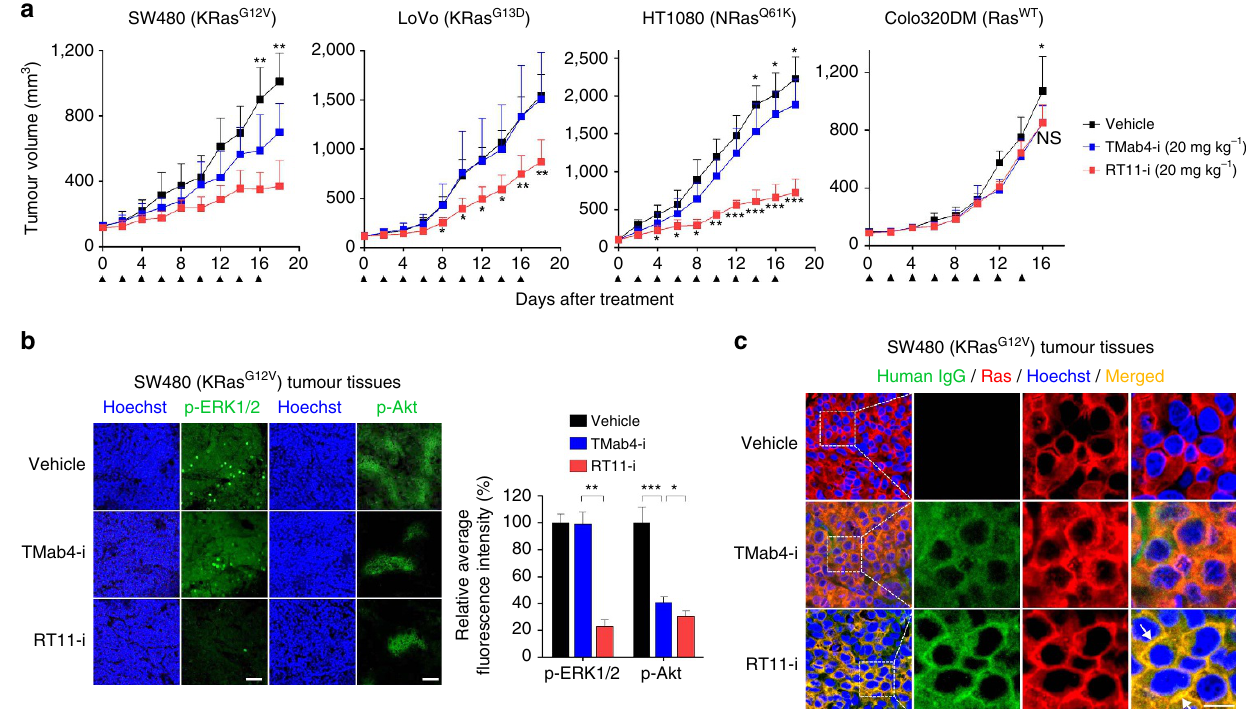
Figure 6 | RT11-i suppresses the in vivo growth of oncogenic Ras mutant tumour xenografts in mice. ( a ) In vivo anti-tumour efficacy of RT11-i compared to that of vehicle and TMab4-i controls, analysed by measuring the tumour volume during treatment of female BALB/c nude mice harbouring the indicated tumour xenografts. Antibodies were intravenously dosed at 20mgkg (cid:3) 1 every 2 d (indicated by the arrows). Error bars, ± s.d. ( n ¼ 8 per group). ( b , c ) Immunohistochemical images showing the levels of p-ERK1/2 and p-Akt ( b ) or cellular penetration and co-localization of antibodies with the active Ras form ( c ) in SW480 tumour tissues excised from mice following treatment described in a . Images are representative of three independent experiments. Nuclei were counterstained with Hoechst33342 (blue). Scale bar, 100 m m in b or 10 m m in c . In b , the right panel shows the percent relative fluorescence intensity compared to that of vehicle-treated control. Error bars, ± s.d. of five random fields for each tumour (two tumours per group). In c , the areas in the white boxes are shown at a higher magnification for better visualization. The arrows indicate the co-localization of RT11-i with activated Ras. In a , b , statistical analysis was performed using a one-way analysis of variance followed by the Newman–Keuls post-test. * P o 0.05, ** P o 0.01, *** P o 0.001 versus TMab4-i; NS, not